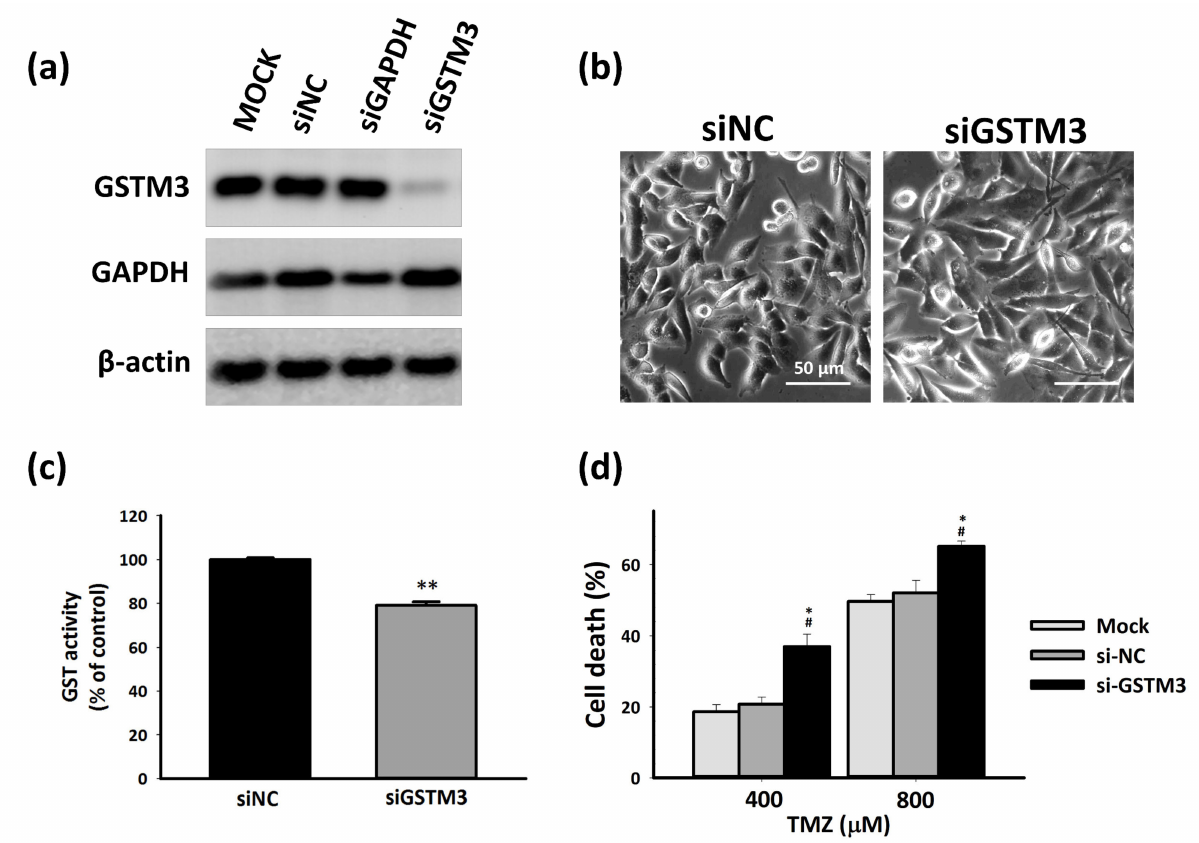
Figure 4. Knockdown of GSTM3 T98G cells. ( a ) Protein expression of GSTM3 and glyceraldehyde-3-phosphate dehydro- genase (GAPDH) in siNC and siGSTM3 T98G cells. β -Actin was used as the loading control. ( b ) Morphology of small interfering RNA (siRNA) negative control (siNC) and GSTM3 (siGSTM3) T98G glioblastoma. Cells were subjected to microscopy at 40 × magnification. ( c ) GST activity of siNC and GSTM3 T98G cells. The reaction mixture contained 100 µ g of cytosolic protein in 0.1 M KPO4 buffer, pH 7.5, containing 1 mM GSH and 1 mM CDNB at 25 ◦ C. Values are expressed as mean ± SD ( n = 3). ** p < 0.001 relative to siNC. ( d ) MTT assays were performed on Mock, siNC, and GSTM3 T98G cells. The MTT assay of T98G cells after 72 h of TMZ treatment. Values are expressed as mean ± SD ( n = 6). * p < 0.05 relative to siNC. # p < 0.05 relative to mock